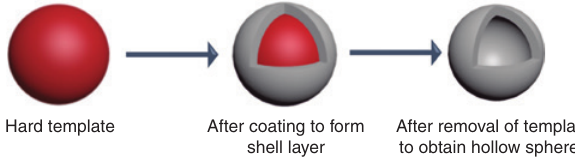
Figure 1: Schematic illustration for hard-templating synthesis